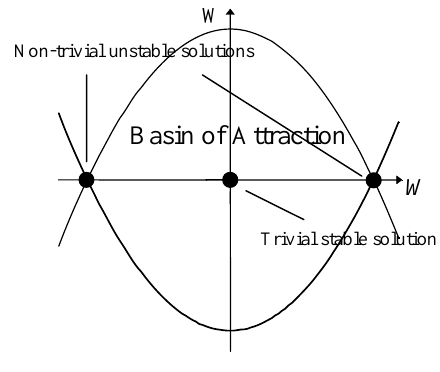
Fig. 2. Basin of attraction of the trivial solution for the laterally unloaded